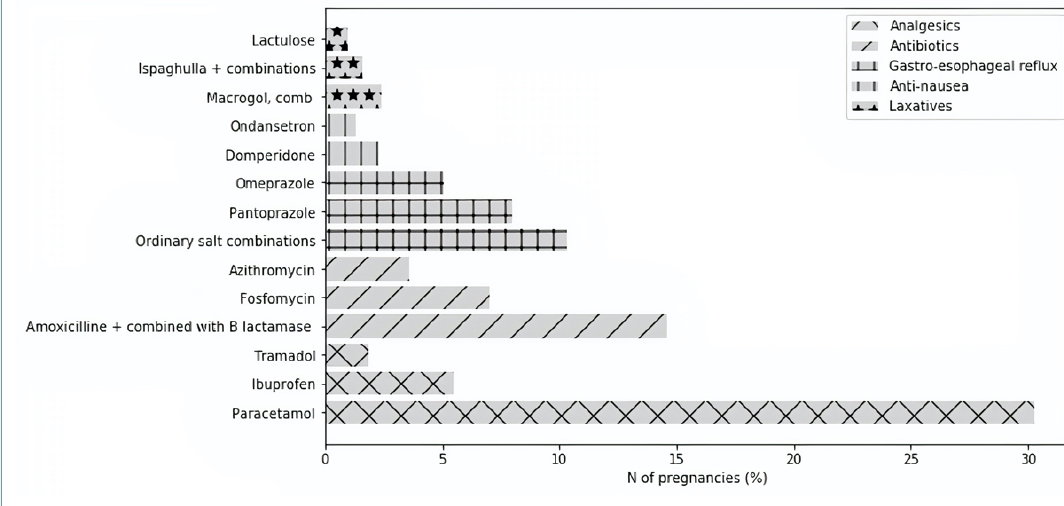
Figure 2: Exposure prevalence to the three most prescribed outpatient active substances per drug group during pregnancy (T1–T3) (extrapo- lated numbers).